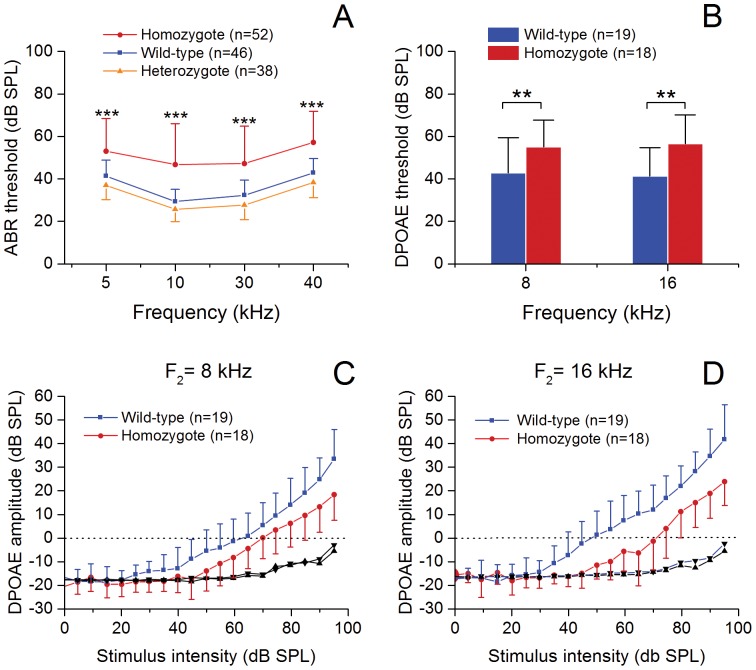
Prestin-CreERT2 mice (+/+) exhibit a reduced hearing sensitivity.A Comparison of the ABR thresholds of Prestin-CreERT2 homozygotes (+/+), heterozygotes (+/-) and wild-type mice at the four tested frequencies. The homozygous mice exhibit elevated thresholds compared with the wild-type mice (two-way ANOVA, F1,384 = 121.0, P<0.001; *** indicates P<0.001 tested by Tukey test). B Comparison of the thresholds of DPOAEs between the Prestin-CreERT2 homozygous mice and wild-type mice for the two tested frequencies (F2 = 8 and 16 kHz). The homozygous mice show elevated thresholds compared with the wild-type mice (Two-way ANOVA, F1,70 = 17.2, P<0.001; ** indicates P<0.01 tested by Tukey test). C and D The comparisons of the input/output functions of the DPOAE between the Prestin-CreERT2 homozygous mice and wild-type mice at the two tested frequencies: F2 = 8 kHz and F2 = 16 kHz. The homozygous mice display the reduced amplitudes of DPOAE at both tested frequencies compared with those observed in the wild-type mice. These results suggest that Prestin-CreERT2 knockin affects cochlear function by interfering with OHC function. n: the number of the cochleae used for each group.